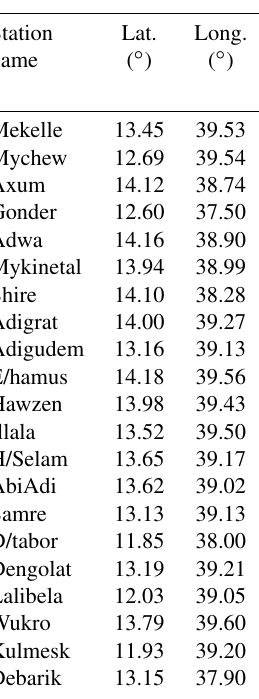
Table 1. General information on rainfall stations, latitude and longitude, altitude (Alt.) in metres above sea level (ma.s.l.), mean annual rainfall (mmyr − 1 ), standard deviation (mmyr − 1 ), and percentage of missing